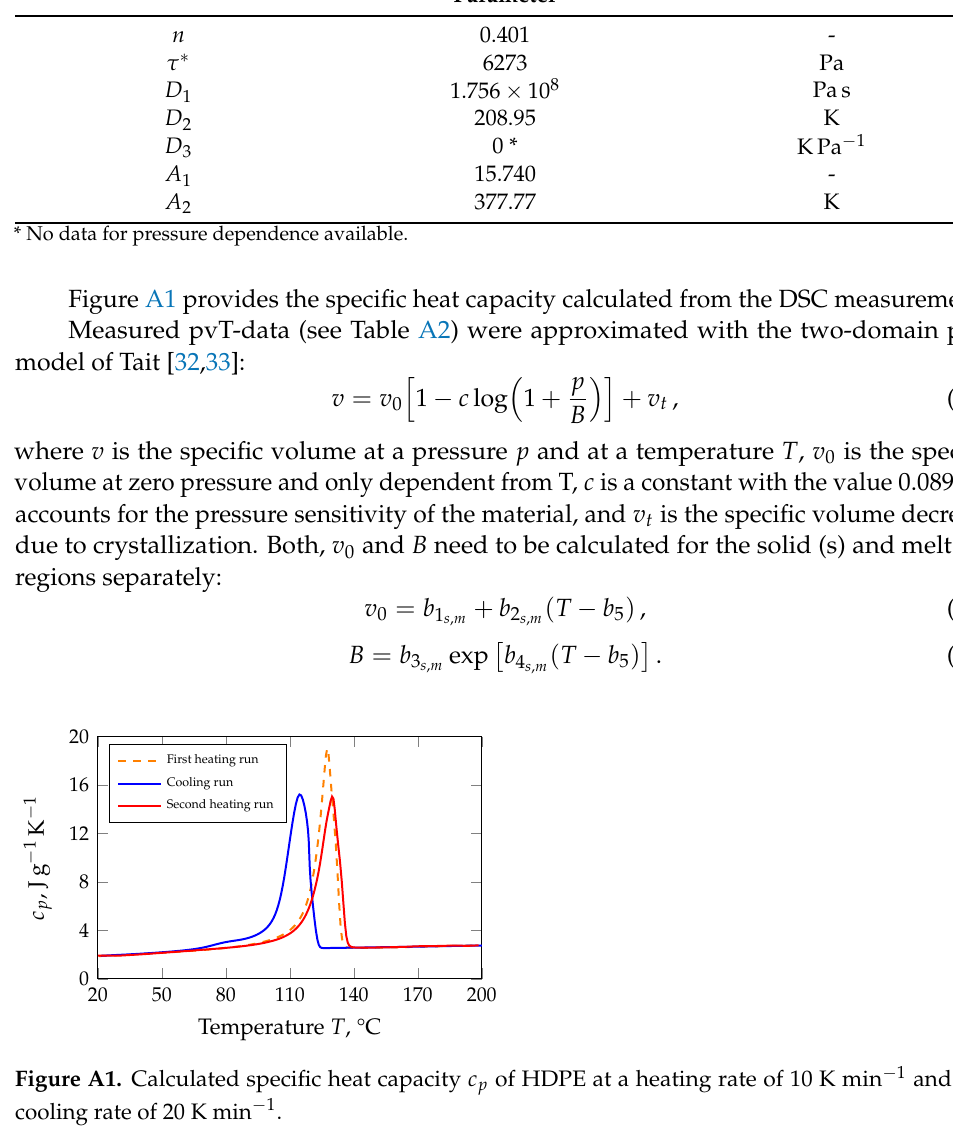
Table A1. Cross-WLF approximation parameters of the applied viscosity model. Parameter